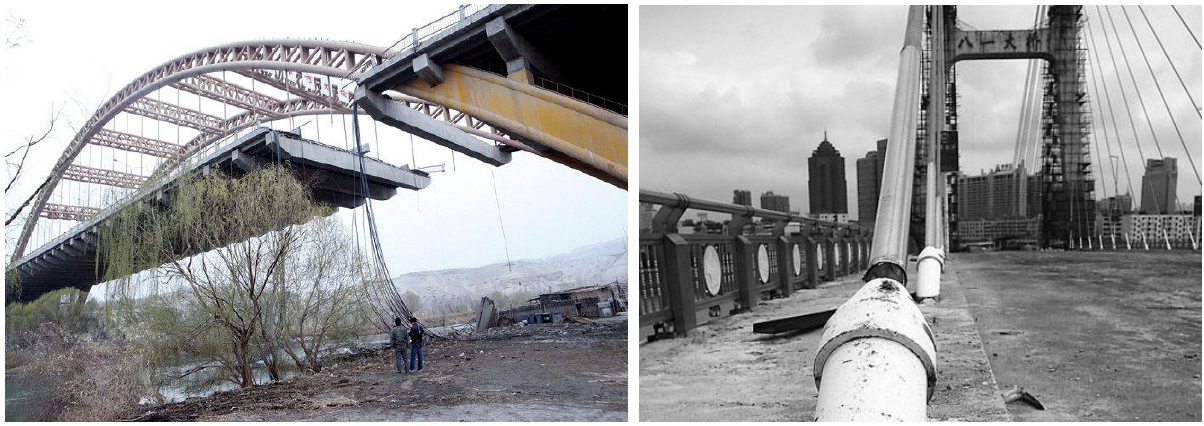
Figure 1. Two recent bridge failures in